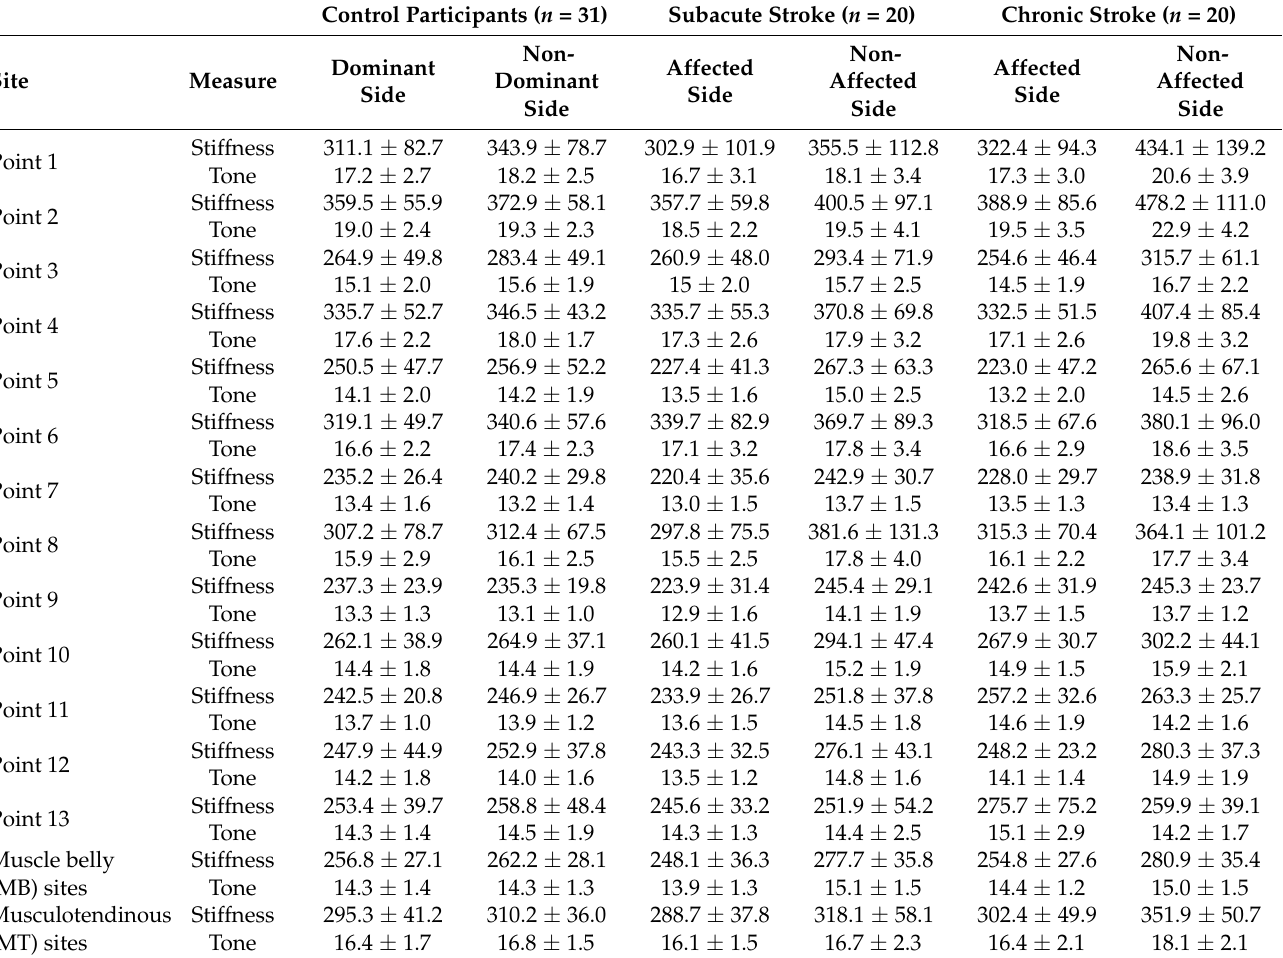
Table 2. Mean ± SD biceps brachii stiffness (N/m) and tone (Hz) over assessed sites (points 1 to 13, MB and MT sites) in stroke patients and controls.